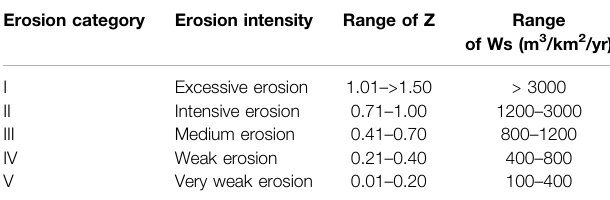
TABLE 5 | EPM erosion categorization and range of erosion coef fi cient (Z) and speci fi c annual gross erosion (Ws). Erosion